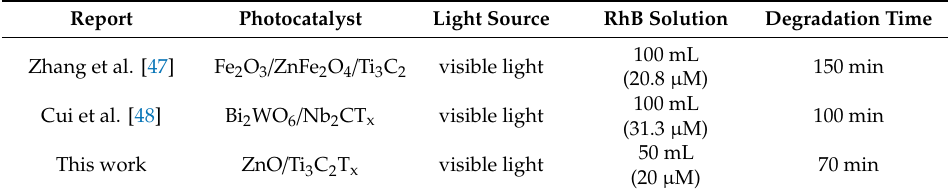
Table 2. Comparison of photocatalytic performance of various photocatalysts.